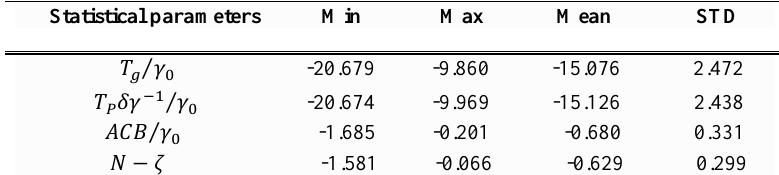
Table 2. The statistical characteristics of GQS based on direct method, unit: meter.